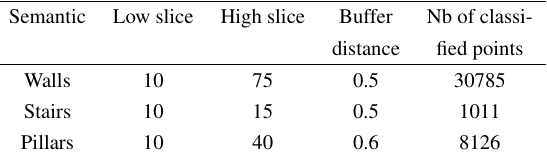
Table 1. Parameters used for classification